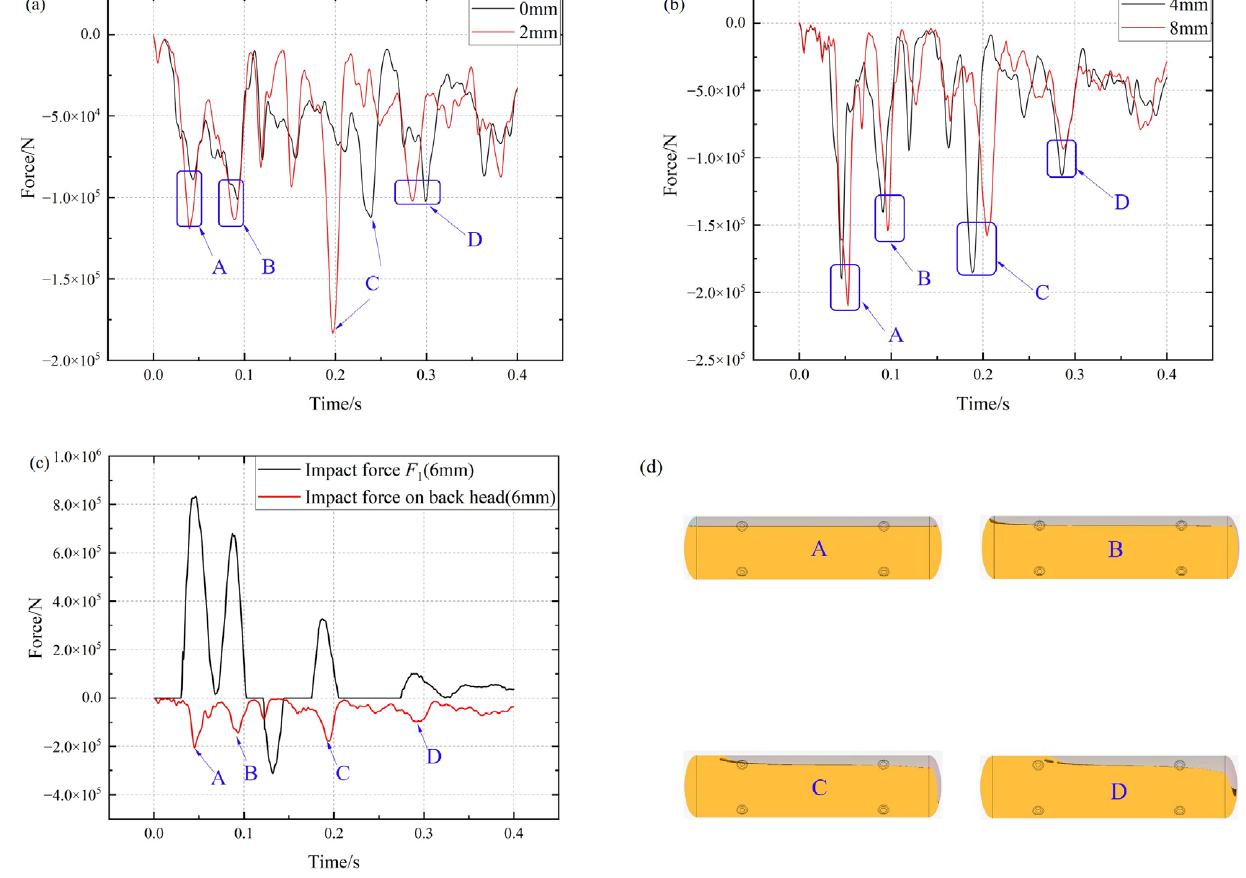
Figure 17. The variation of LNG impact force: ( a ) at 0 and 2 mm initial clearance; ( b ) at 4 and 8 mm initial clearance; ( c ) relationship with the F 1 ; ( d ) LNG free surface at peak impact force times.